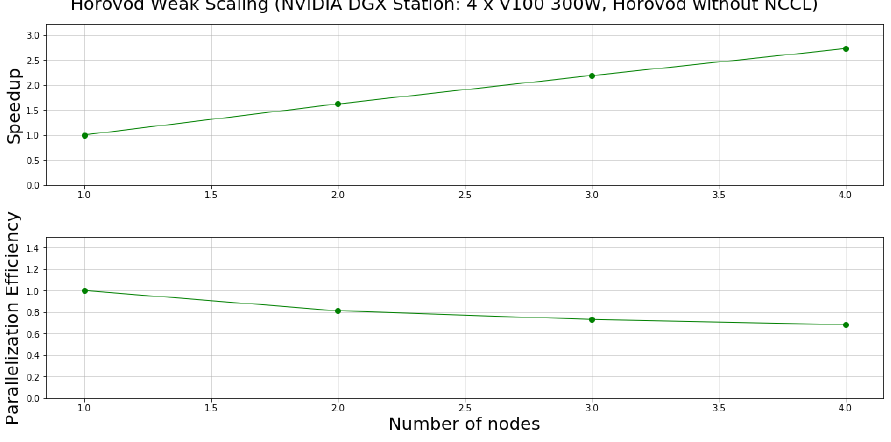
Figure 6. Comparison plot of how our model scales to multiple GPUs